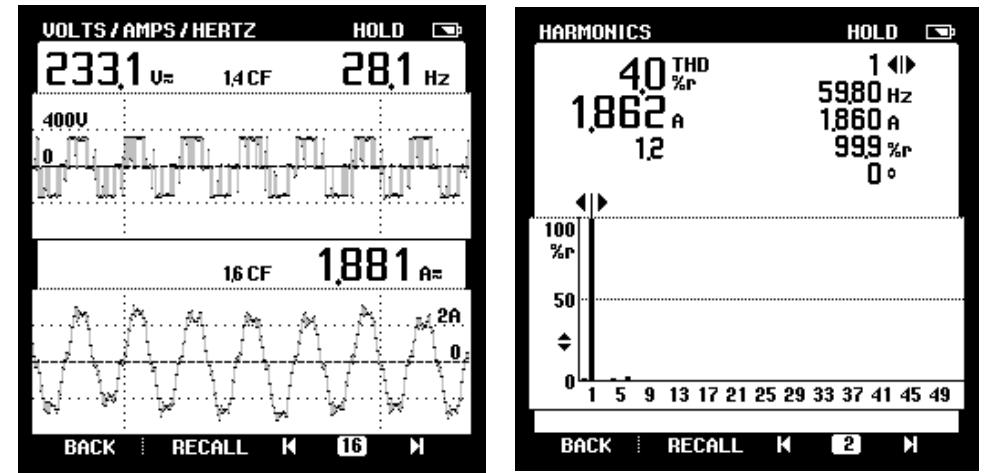
Figure 16. Real-time harmonics of the current waveform.